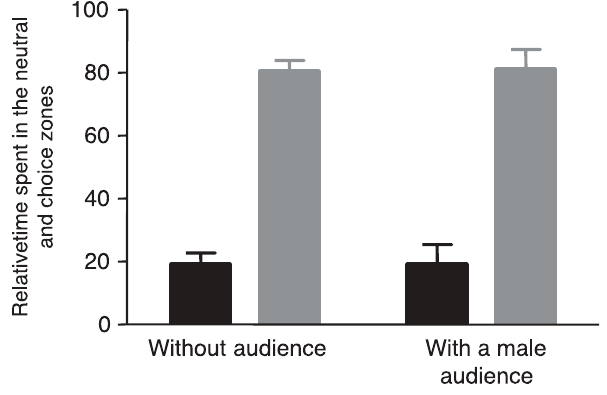
Figure 2. Mean ( 6 SEM) percent of time spent by focal males in the neutral zone (black bars) and in the choice zone (grey bars) of the apparatus in both experimental conditions (i.e. with and without a male audience).